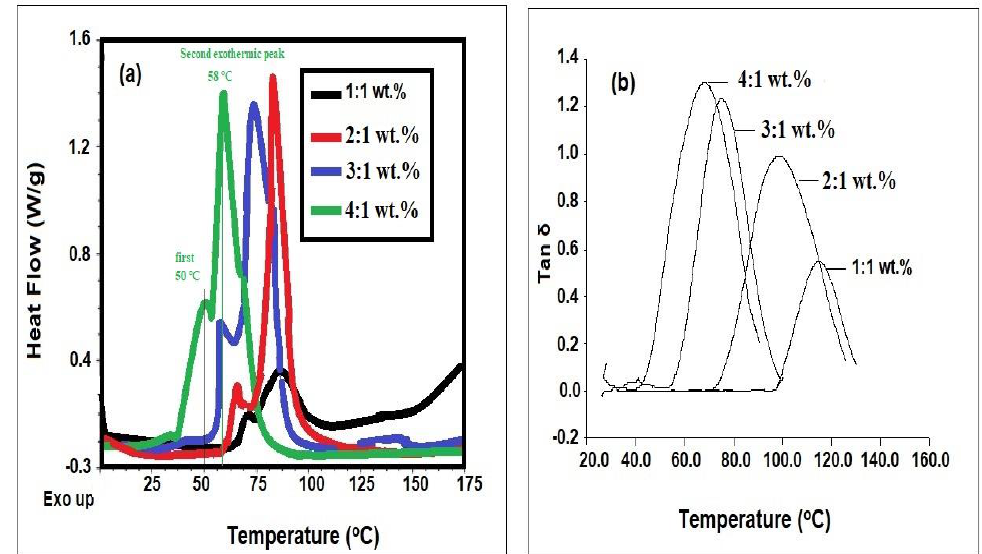
Figure 9. Thermal characteristics of DGEB / PAIIL using ( a ) DSC and ( b ) DMTA thermograms.